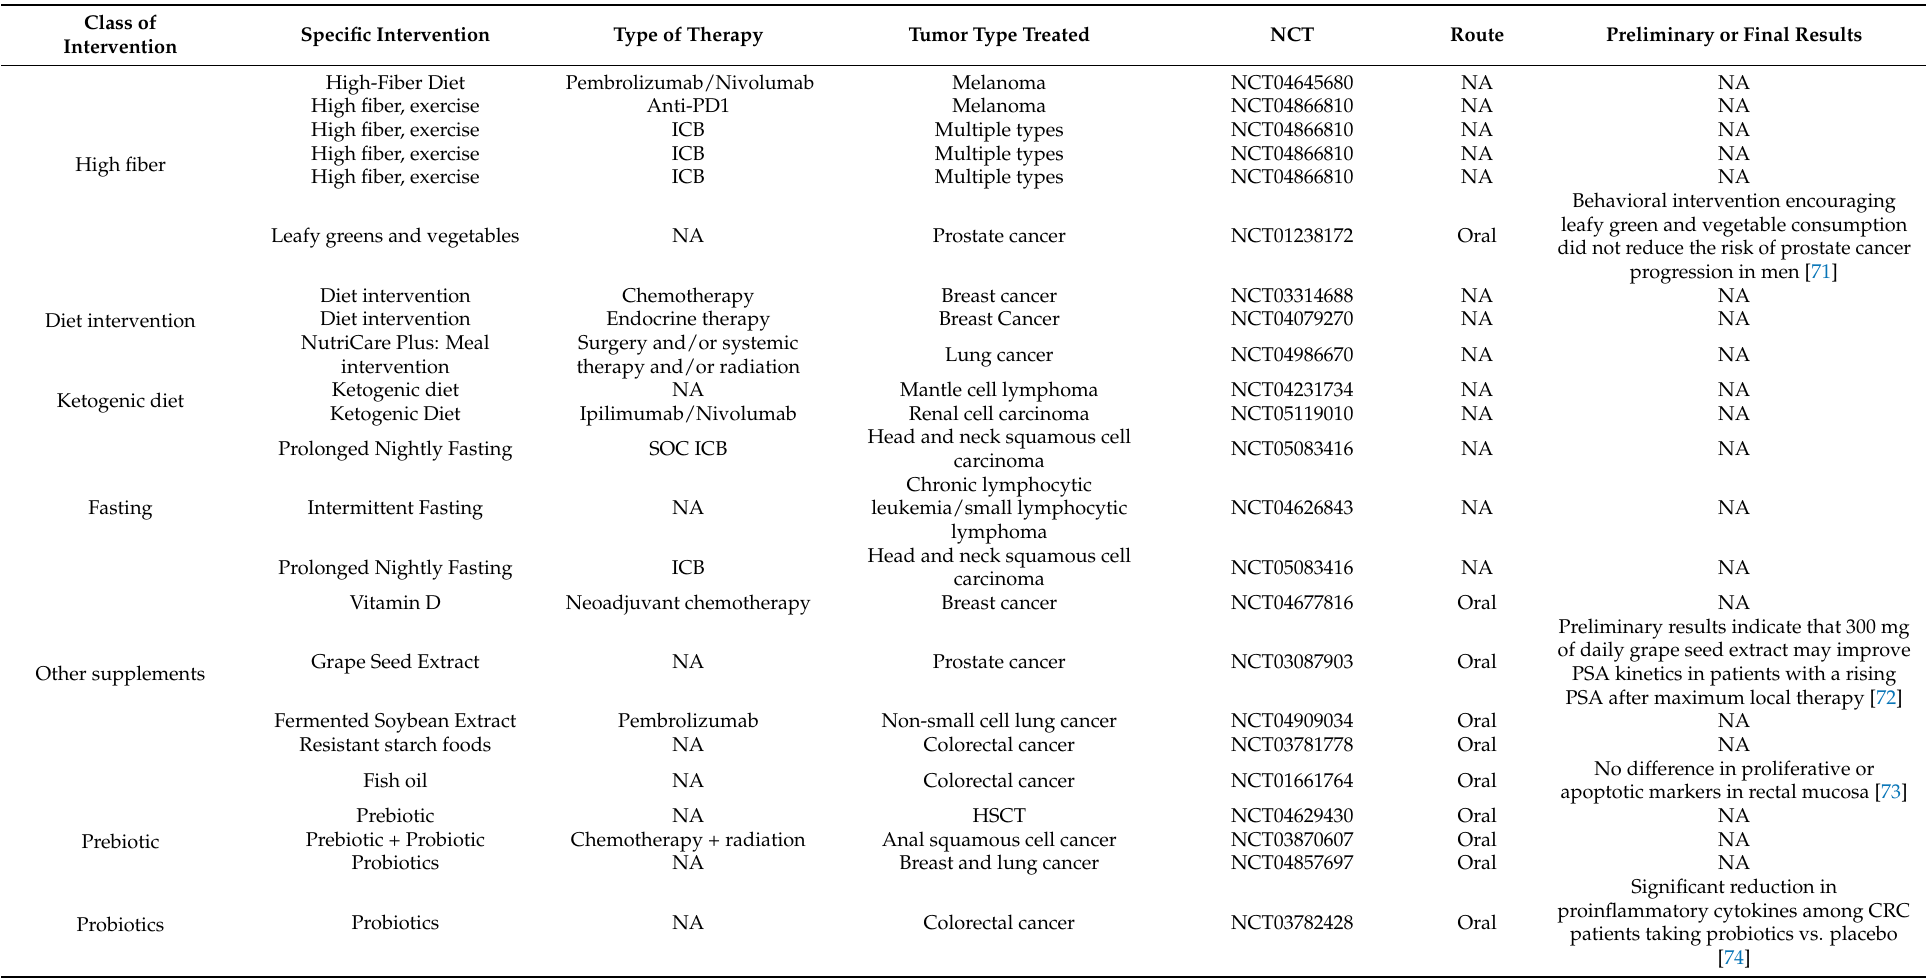
Table 2. Current trials in diet/supplements and probiotics/prebiotics in cancer and cancer therapy